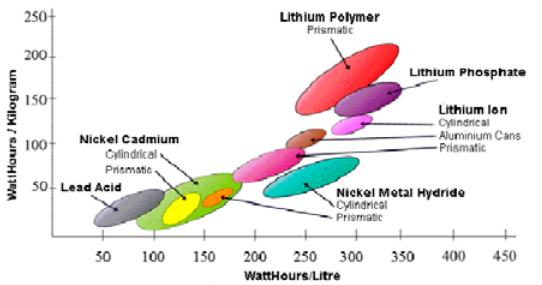
Fig. 4. Volume and weight for several type of energy storage